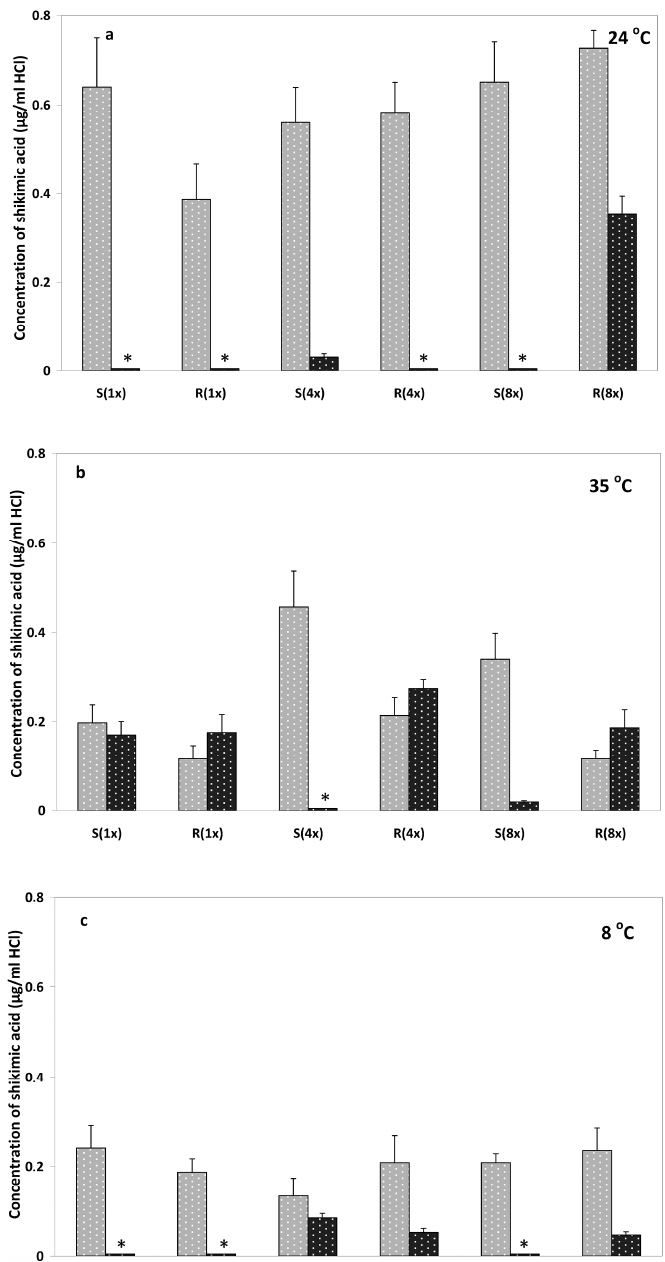
Figure 1. Shikimic acid determination at four days after treatment (DAT). Shikimate levels are reported as micrograms of 1 shikimic acid per mL of HCl solution ( a ) at 24 °C; ( b ) at 35 °C; ( c ) at 8 °C (grey columns represent measurements taken from plants grown in light conditions, whereas black columns in dark conditions). Asterisks denote values close to zero.